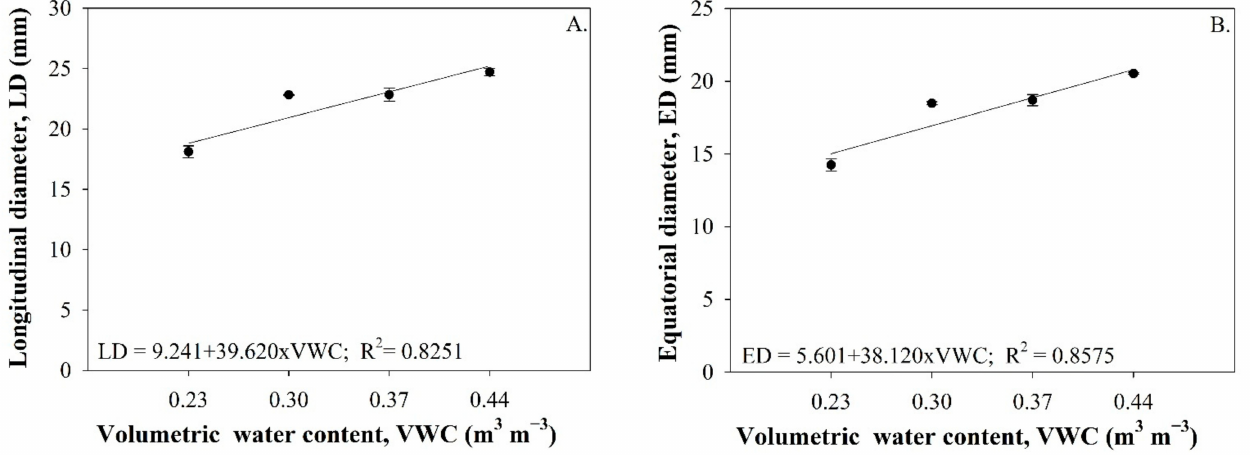
Figure 3. Longitudinal ( A ) and equatorial ( B ) diameter of two cherry tomato cultivars in response to increasing